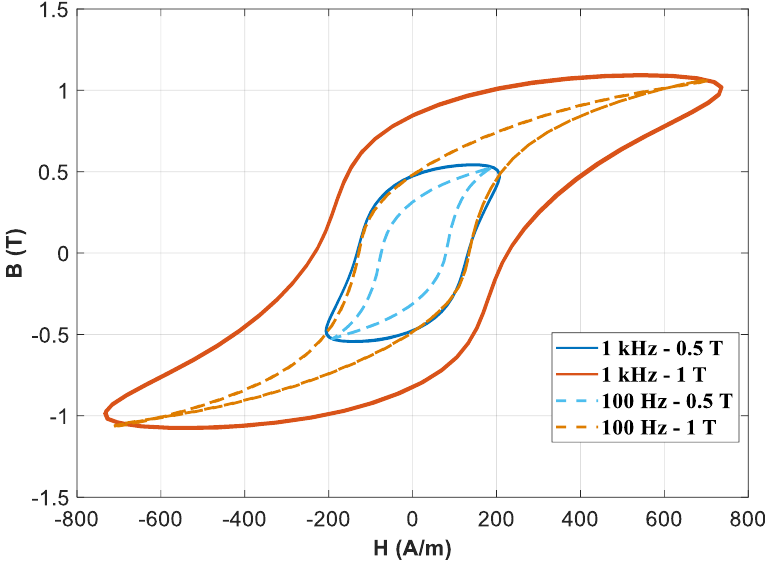
Figure 15. Comparison between the BH loop at low and high frequencies under the same magnetic flux density.